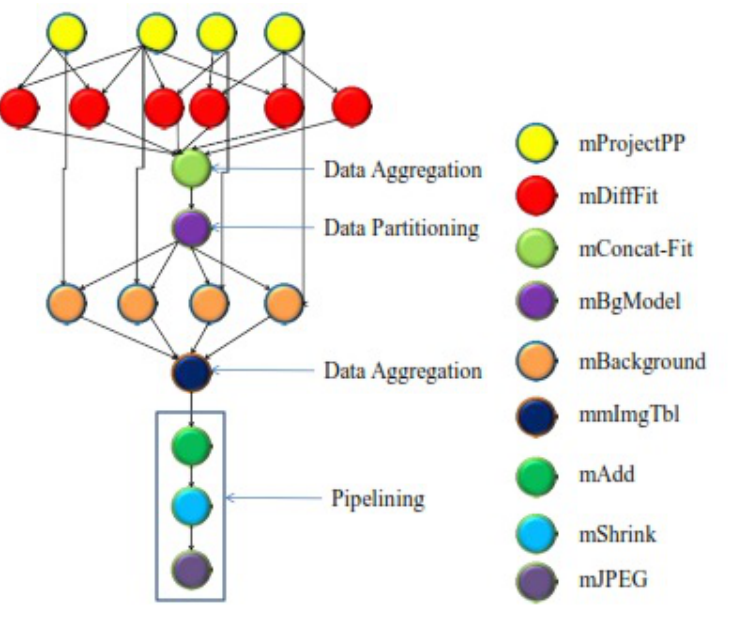
Figure 5. Montage workflow.